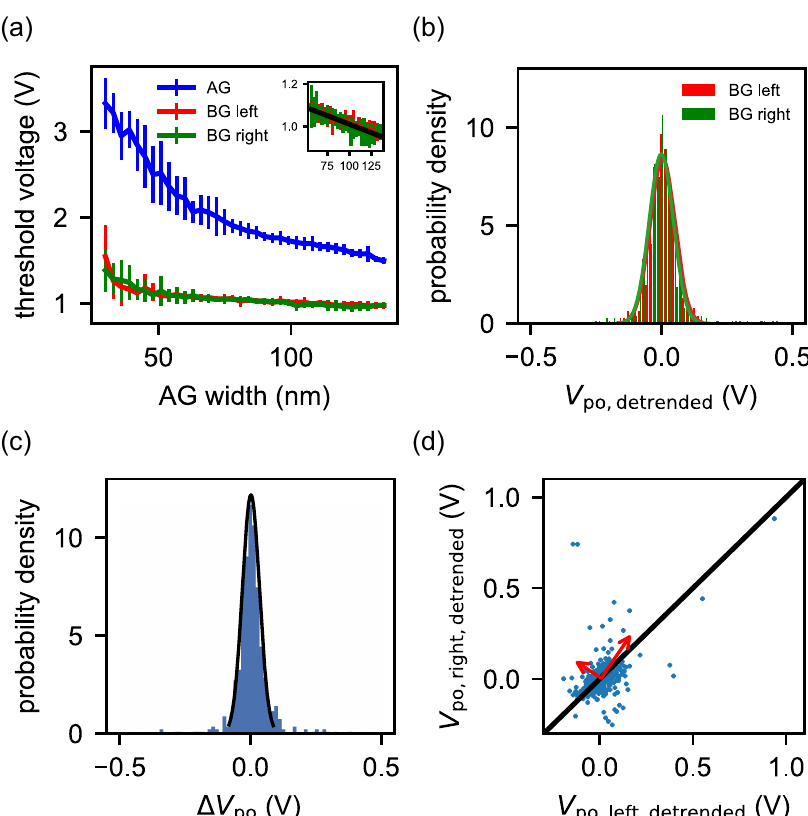
Fig. 3 Statistical analysis of the crossbar electrical characterization. a Turn-on and pinch-off voltages as a function of accumulation gate width with standard deviations. Each point is an average over a row of unit cells in Fig. 2c with identical AG width W but differing BG spacing L . The inset is an enlargement of the pinch-off voltages where the associated turn-on voltage is always below 3V, with a linear fi t (black line). b Probability density histogram of the pinch-off voltages measured throughout the grid where V to < 3V, without the linear gate geometry trend. The colored lines are Gaussian fi ts for both distributions. c Probability density histogram of the pinch-off differences Δ V po (blue) between the right and left barriers within the same FET and a Gaussian fi t thereof (black line). d Pinch-off values of both barriers for each FET plotted against each other with the linear gate geometry trend removed. The principal components of the data are depicted as red arrows and a diagonal black line is a guide for the eye. Disorder contributions with length scale smaller than the barrier spacing should cause dispersion evenly in the plane. All disorder contributions at larger-scale cause variance predominantly in the (y = + x)